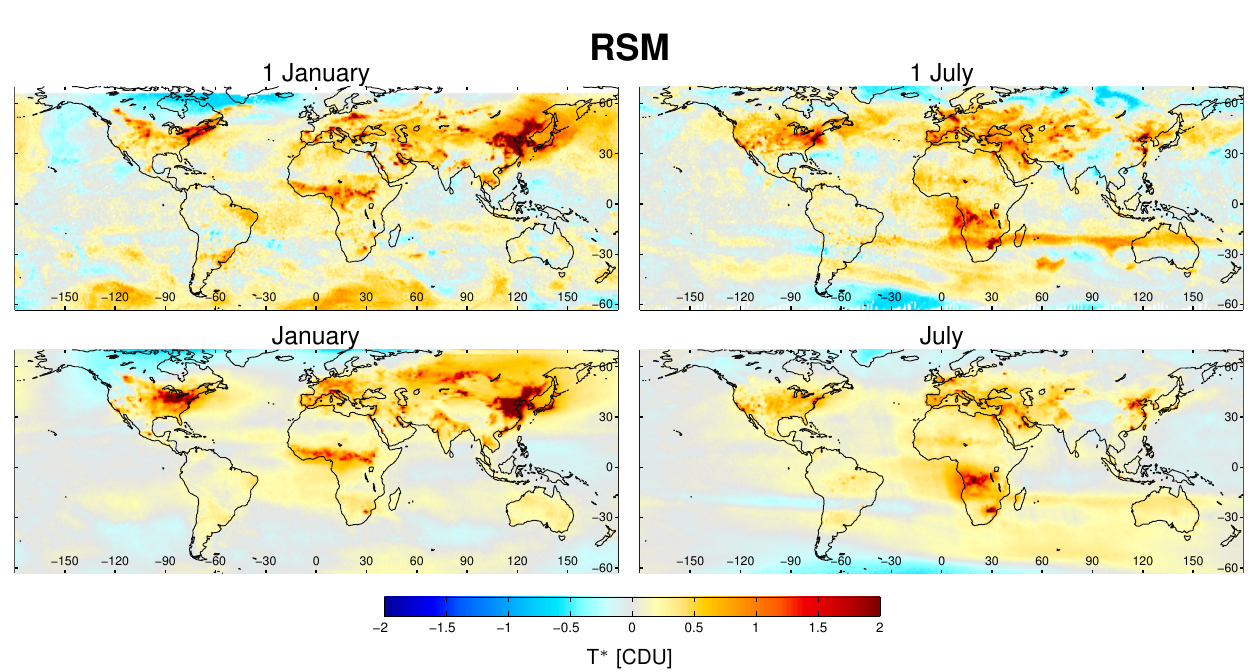
Figure 4. OMI tropospheric residues T ∗ based on RSM for January (left) and July (right) 2005 for the first day of the month (top) and the monthly mean (bottom).